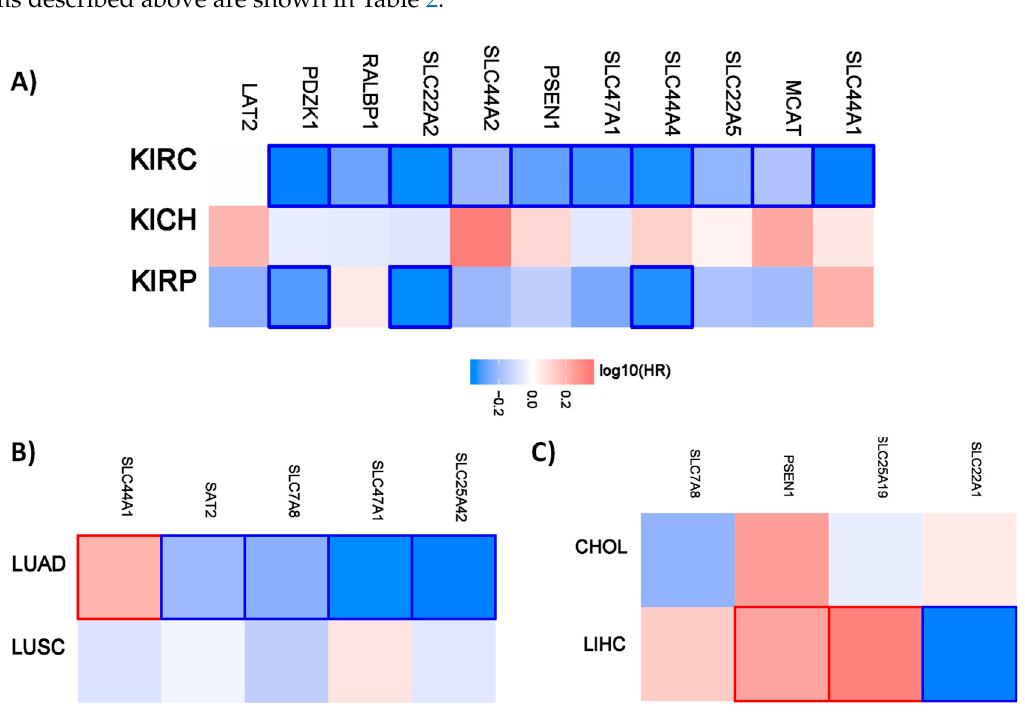
Figure 1. Hazard ratio of the organic cation transporter expression in different renal and lung cancer subtypes. The hazard ratio (HR) was calculated for ( A ) the different renal cancer (renal clear cell carcinoma (KIRC), renal papillary cell carcinoma (KIRP), and chromophobe renal cell carcinoma (KICH). ( B ) The hazard ratio for lung adenocarcinoma (LUAD) and lung squamous cell carcinoma (LUSC). ( C ) The hazard ratio for cholangiocarcinoma (CHOL) and liver hepatocellular carcinoma (LIHC). The red and blue color denote higher and lower risk, respectively. The rectangles with frames represent the statistically significant HR ( p < 0.05).